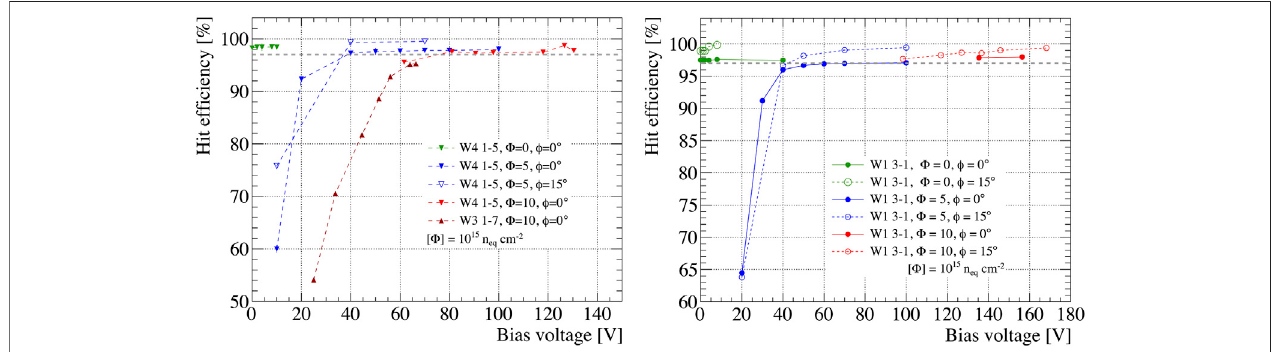
FIGURE 9 | Hit ef fi ciency as a function of the bias voltage for RD53A modules with CNM 3D sensors from run 9761 before and after irradiation. On the left (right) resultsofsensorswith50 × 50 − 1E(25 × 100 − 1E)pixelgeometryobtainedwiththeDifferential(Linear)front-endareshown.TheBDAQreadoutsystemhasbeenusedfor tuning and data-taking. The modules are tuned to a mean threshold of 1 ke. A systematic uncertainty of 0.3% is associated to all ef fi ciency measurements. Partially adapted from Reference [25, 26].